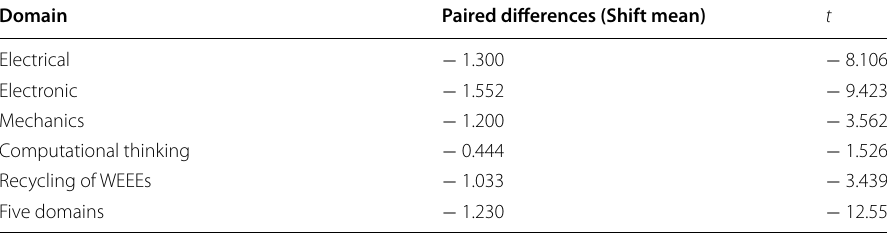
At the 5% significance level, the data provides sufficient evidence to conclude that the mean of the post‑test is higher than the mean of the pre‑test with exception computational thinking domain that presented a p > 0.05 (p was no significant change between the pre‑and post‑test for this domain